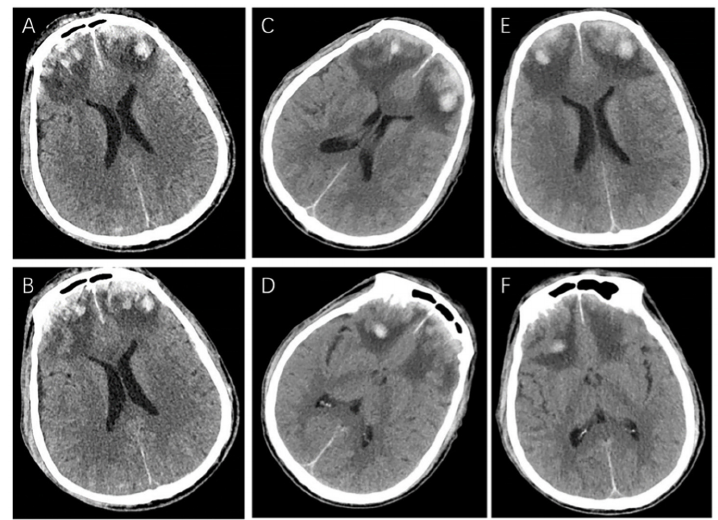
Figure 2. The craniocerebral CT examination during conservative treatment. The craniocerebral CT examination on the fifth day of admission showed a low-density edema zone around the hematoma ( A , B ). The craniocerebral CT examination on the ninth day of admission showed the extent of edema was enlarged ( C , D ). The repeated CT examination on the tenth day of admission showed little changes ( E , F ).